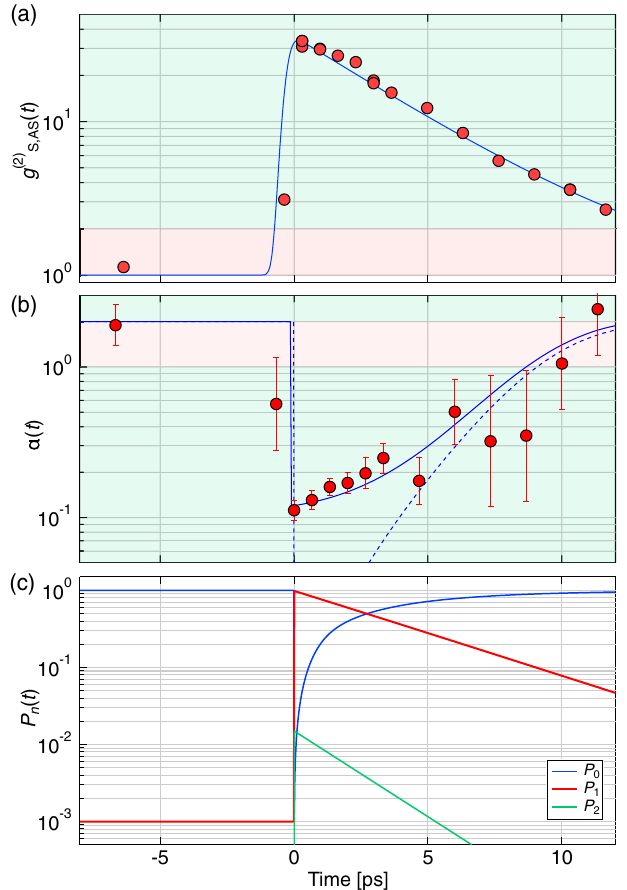
FIG. 4. Decay of vibrational Fock state. Measured Stokes – anti- Stokes correlations (a) and heralded vibrational mode intensity correlation (b) as a function of write-read delay. The measure- ments (full circles) are taken with a pulse energy of 62 pJ in the write pulse and 409 pJ in the read pulse, with an acquisition time of 60 min for all points except the one at − 6 . 3 ps, which was acquired over 8 h. Statistical error bars are obtained using the method described in Ref. [17]. Full circles are measured data and blue lines are from the model; see main text and Eq. (11). The prediction from the model without the added noise on the anti- Stokes detectors is shown with a dashed line in (b). Green bands in panels (a) and (b) show the region where a nonclassical model is required to explain the observations; red bands indicate where a classical model suffices. (c) Fock state distribution of the condi- tional vibrational mode inferred from the data via our